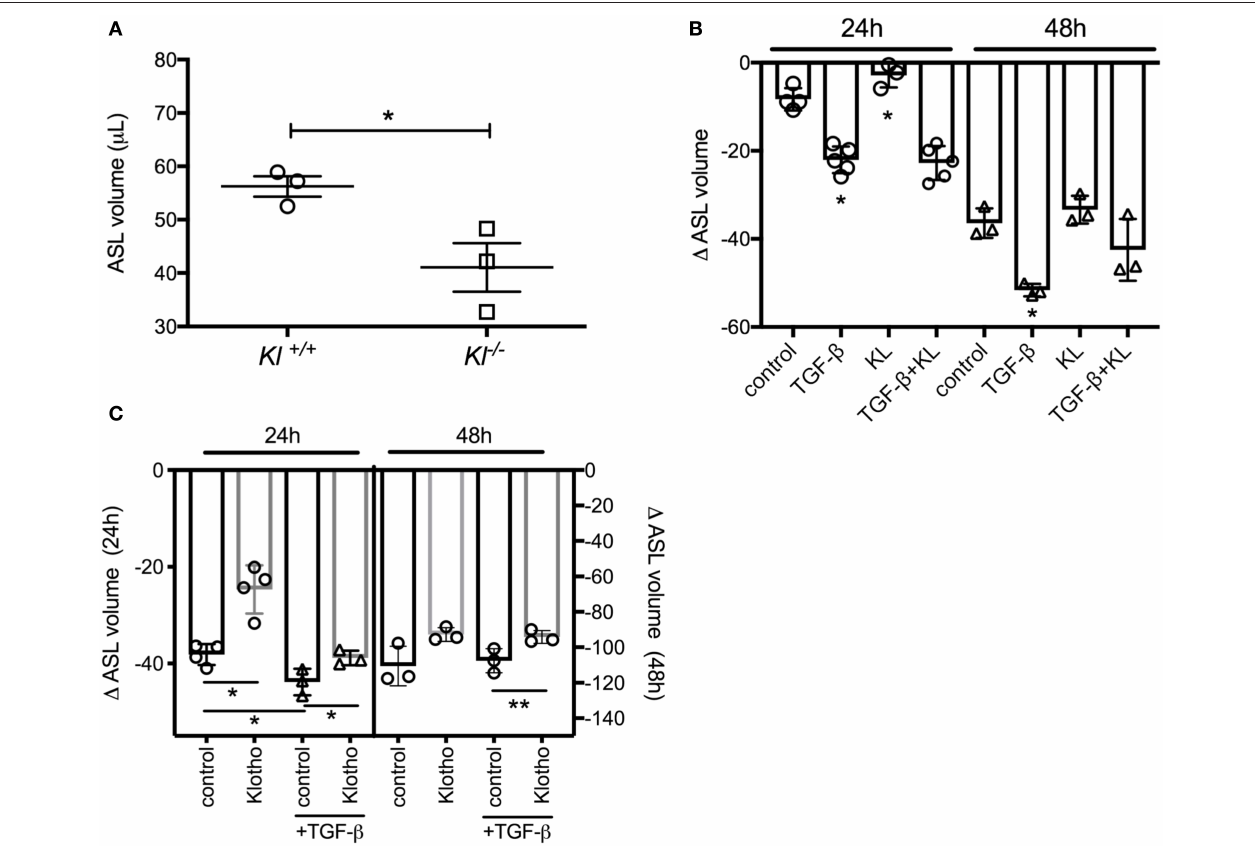
FIGURE 2 | (A) Dot plot showing a significant decrease of ASL volume in murine tracheal epithelial cells (MTECs), isolated from kl − / − mice and their wild type littermates and using meniscus scanning. (B) Bar graphs indicating ASL volume change in human bronchial epithelial cells (HBEC), differentiated at the ALI interface and treated with TGF- β (2.5ng/ml) ± recombinant KL (100ng/ml) for 24 and 48h. (C) ASL volume change in HBEC, infected with either control or klotho and differentiated at the ALI interface and effect of TGF- β (2.5ng/ml) for 24 and 48h. ( n = 3 independent experiments showing mean ± S.E. with * P < 0.05 and ** P <